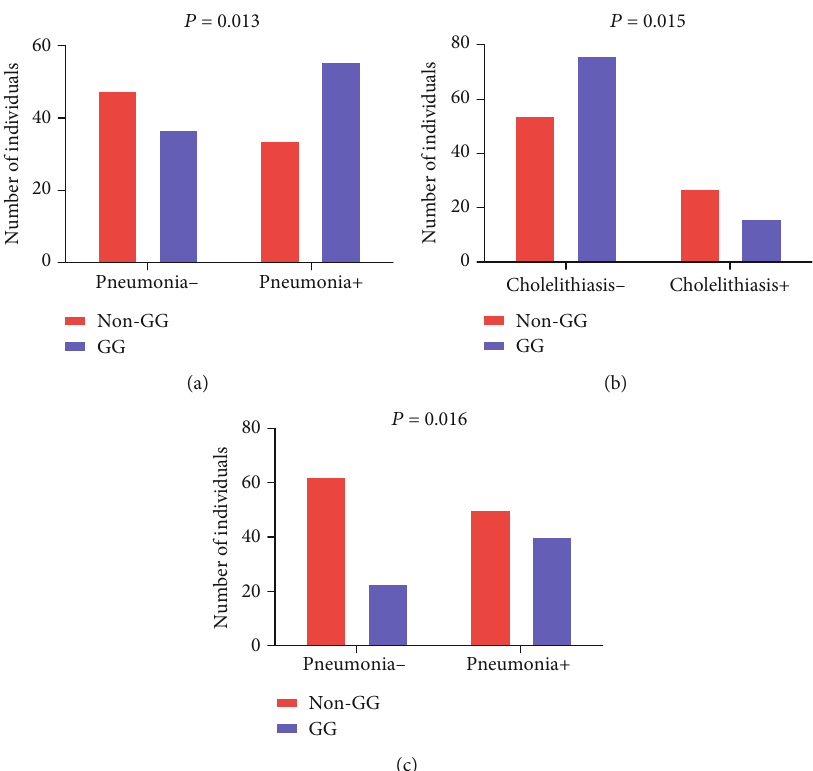
Figure 4: Associations between the GG and CGG haplotypes and clinical manifestations in individuals with SCD. GG haplotype was associated with (a) a previous history of pneumonia, while non-GG haplotypes were associated with (b) a previous history of cholelithiasis. The CCG haplotype was associated with (c) a previous history of pneumonia (all P values obtained by the Chi-square test).